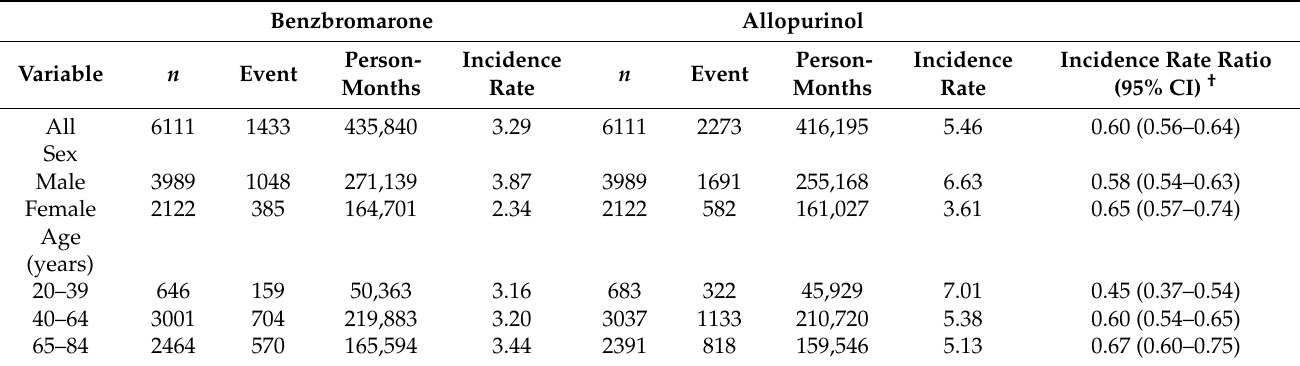
Table 2. Incidence density of the first gout flare between the benzbromarone and allopurinol groups. Benzbromarone